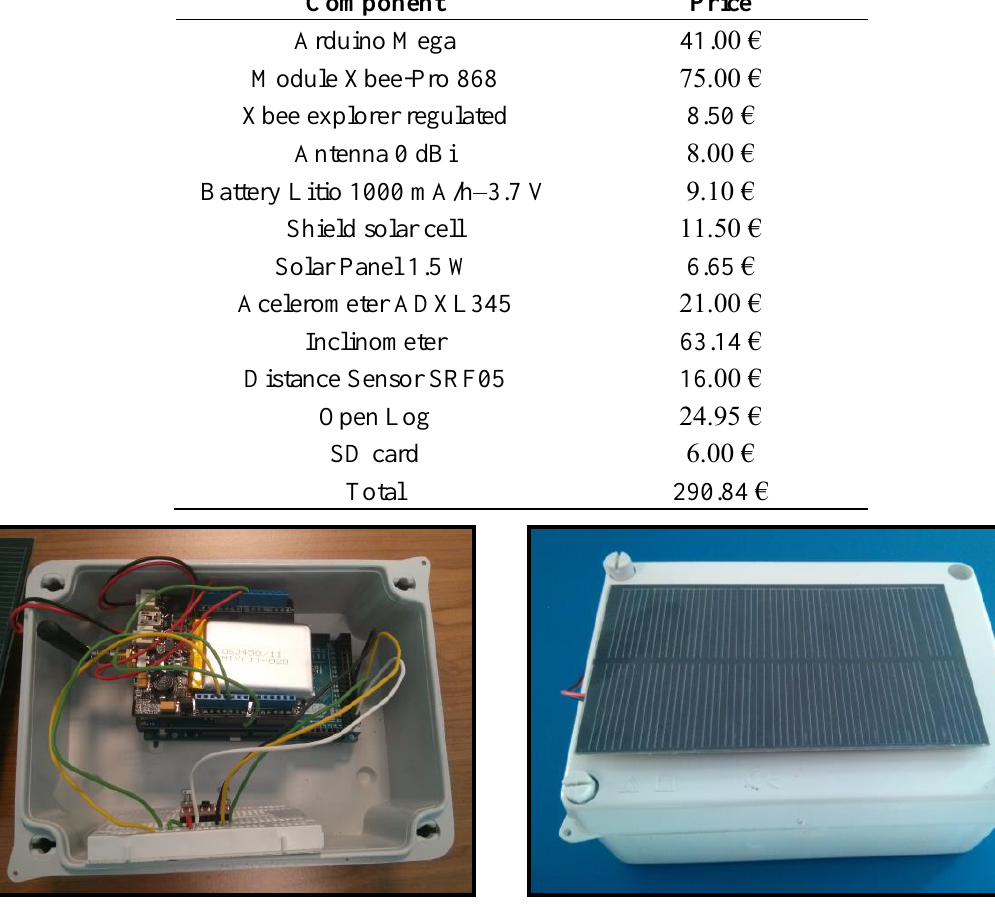
Figure 13. Sensor4PRI